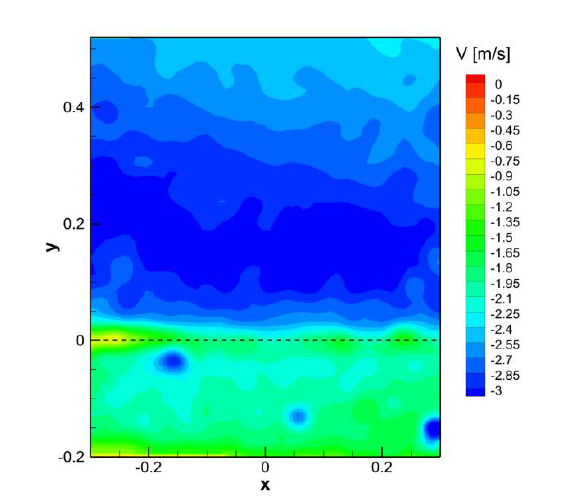
Fig. 3. Mean of-plane velocity component with in-plane velocity vector components. Re = 0.5M.